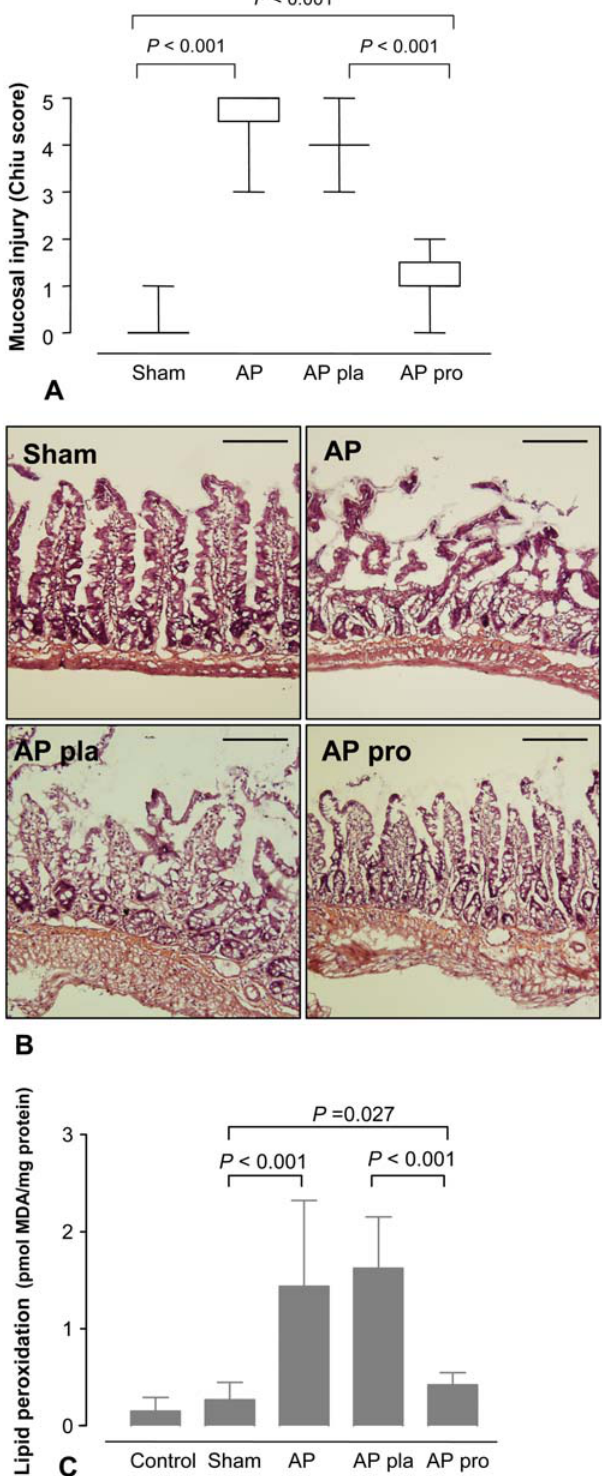
Figure 5. Probiotics attenuated acute pancreatitis-associated mucosal damage. After 5 days of pre-treatment with placebo (pla, n=12) or probiotics (pro, n=12), rats were subjected to acute pancreatitis (AP, n=12), or a sham-procedure (n=12). (A) Sections of ileum were H&E stained and graded according to Chiu et al. (25). The graph shows median ( 6 range). Comparisons were performed using Kruskal-Wallis followed by Mann–Whitney U test. (B) Compared